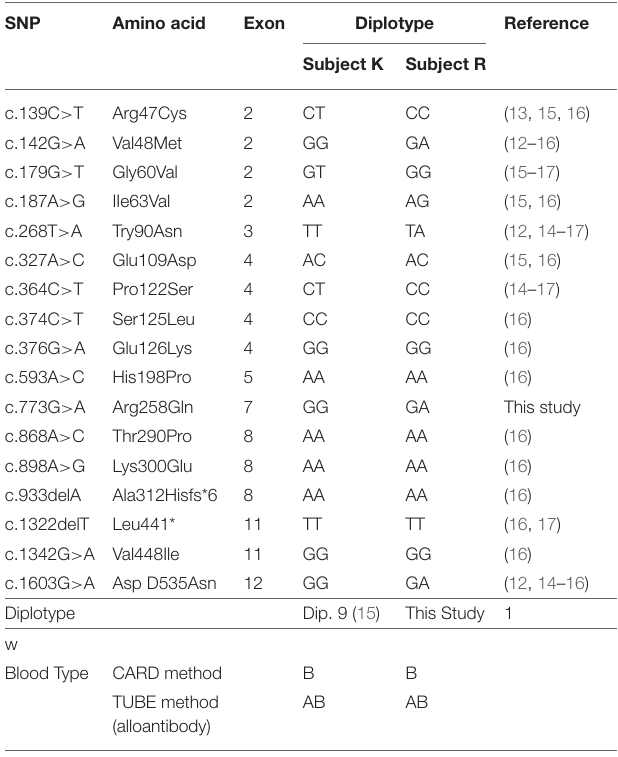
TABLE 2 | Cat CMAH gene variants in cats showing inconsistencies between CARD method and alloantibody tests. SNP Amino